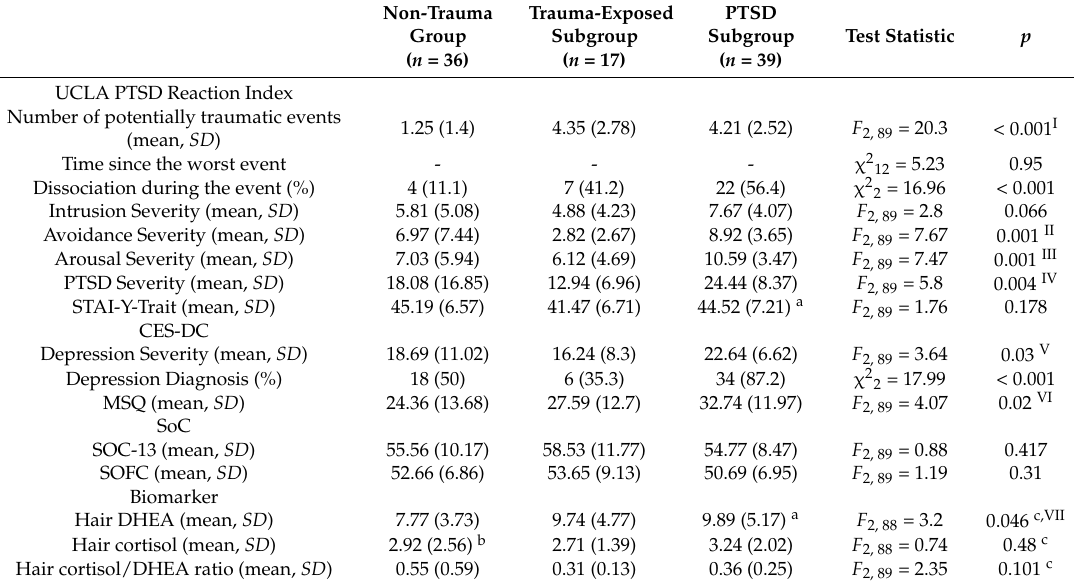
Table 2. Clinical and endocrine variables of study groups (non-trauma, trauma-exposed and PTSD participants) based on the UCLA PTSD Reaction Index for DSM IV, Child